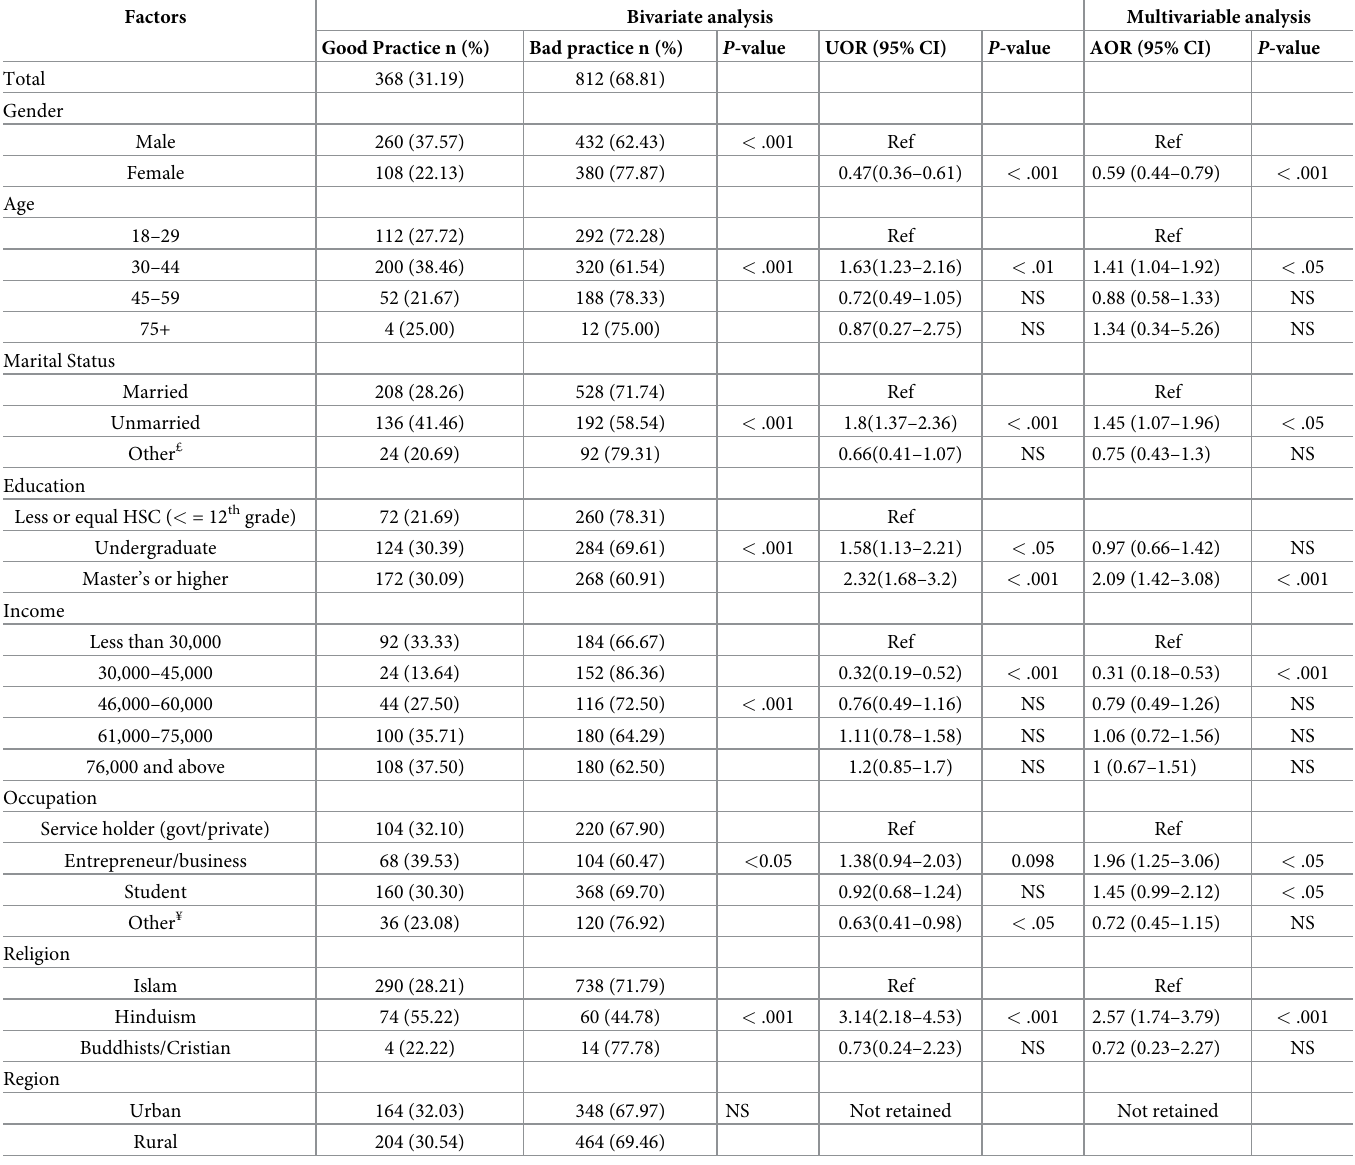
Table 4. Associated factors with practice toward TB among the